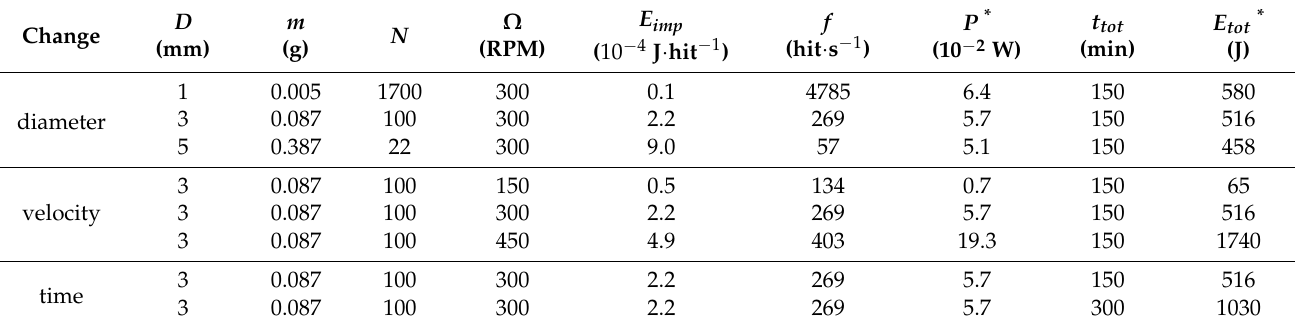
Table 4. Basic parameters of milling and characteristic energies of milling calculated according to [21,22]. D —diameter of milling ball, m —the mass of the ball, N —the number of balls, ω —angular velocity of milling disc, E imp — impact energy, f —frequency of hits, P —the power of milling, t tot —the total time when the disc was rotating during the milling process, transferred during the milling. E tot —total energy